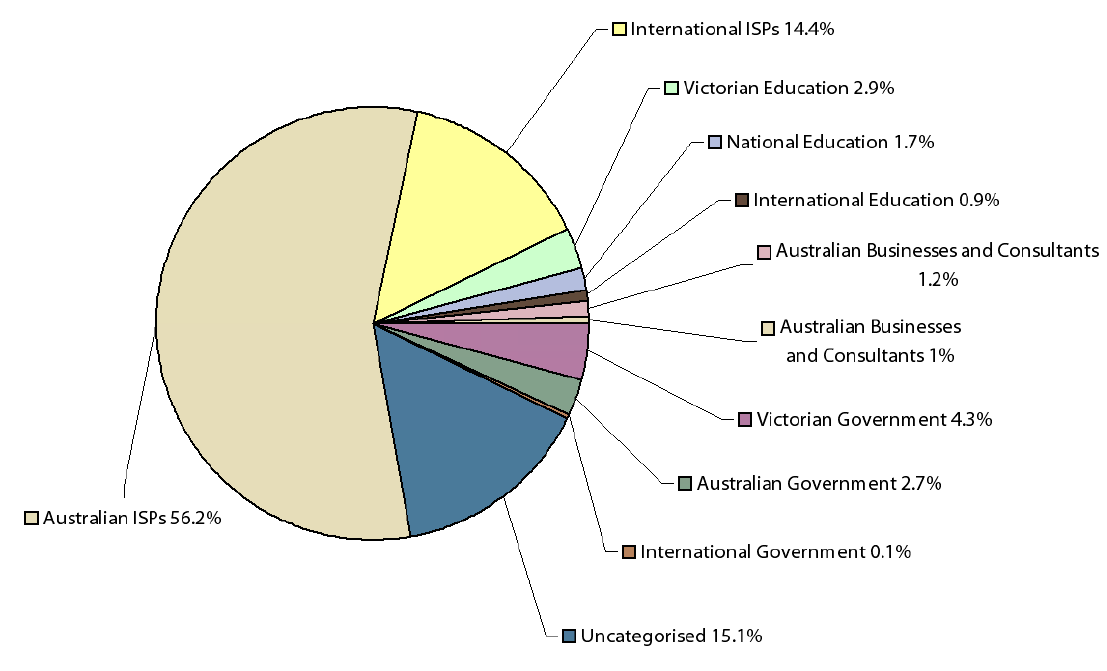
Figure 19. IP tracking profile for all soil and landform related content accessed in the 12 months to June